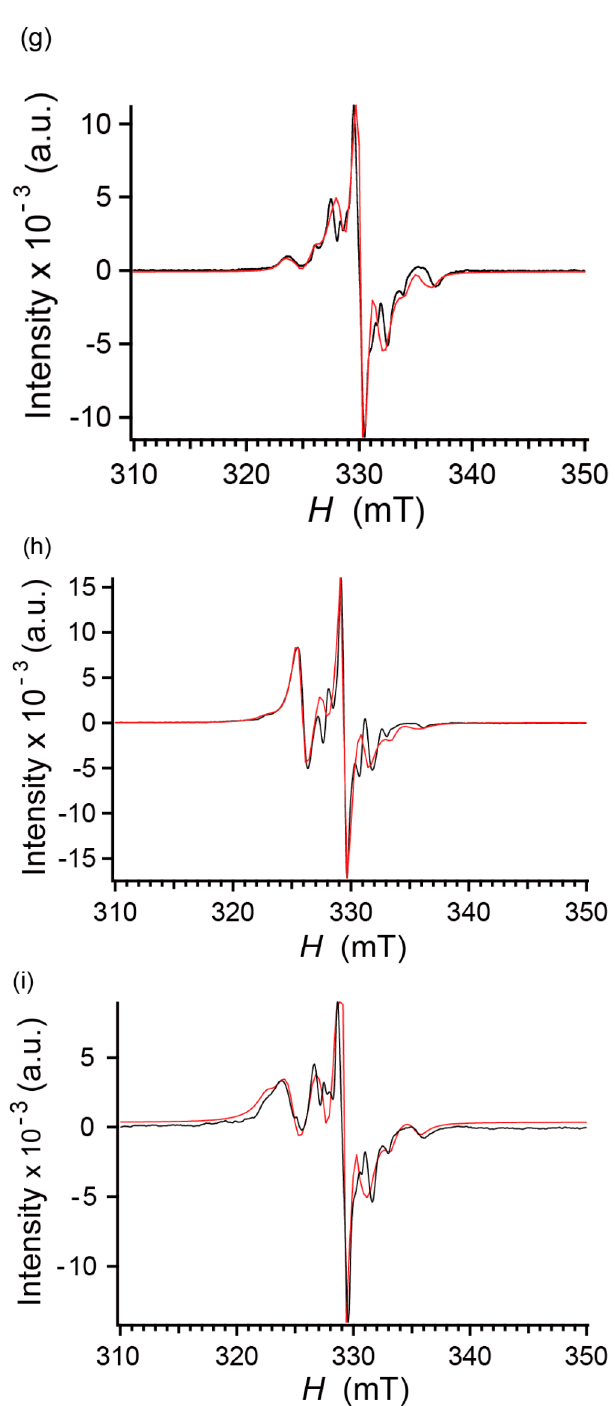
Figure 7. Electron spin resonance (ESR) spectra for 1 – 3 , measured on single crystals. Anisotropy of the g -values at RT in: ( a ) 1 ; ( b ) 2 ; and ( c ) 3 ; observed (red crosses) and best fit (black sine curves). Black arrows designate the angle θ corresponding to the orientation of the crystal shown by the arrows. Comparison of the ESR spectra under dark (black) and UV irradiated (red) conditions at 123 K for: ( d ) 1 ( θ = 0); ( e ) 2 ( θ = 0); and ( f ) 3 ( θ = 45°). Comparison of the observed (black) and simulated (red) ESR spectra under UV irradiated conditions for: ( g ) 1 (from [68]); ( h ) 2 ; and ( i ) 3 . The UV irradiated spectra are the same as those in ( d – f ). The comparison between the observed and simulated ESR spectra in the dark for 1 – 3 and the parameters for all spectral simulation are shown in the Supplementary Materials (Figures S4 and S5 and Tables S4 and S9, respectively).